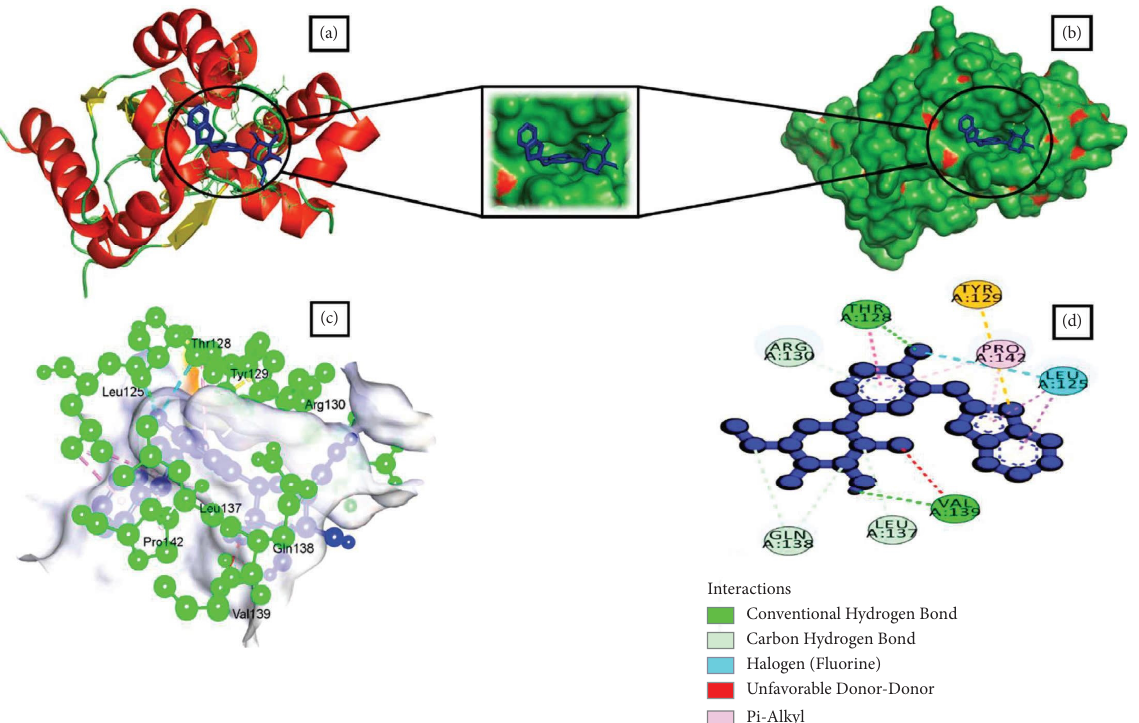
Figure 3: Schematic representation of Shikimate kinase_CHEMBL2018096 complex. (a) Pose view of Shikimate kinase_CHEMBL2018096 complex. (b) Surface view of Shikimate kinase_CHEMBL2018096 complex. Here, protein is in red, yellow, and green color and ligand is in blue color. (c, d) 3D and 2D interaction of Shikimate kinase_CHEMBL2018096 complex. Here, protein is in green color and ligand is in blue